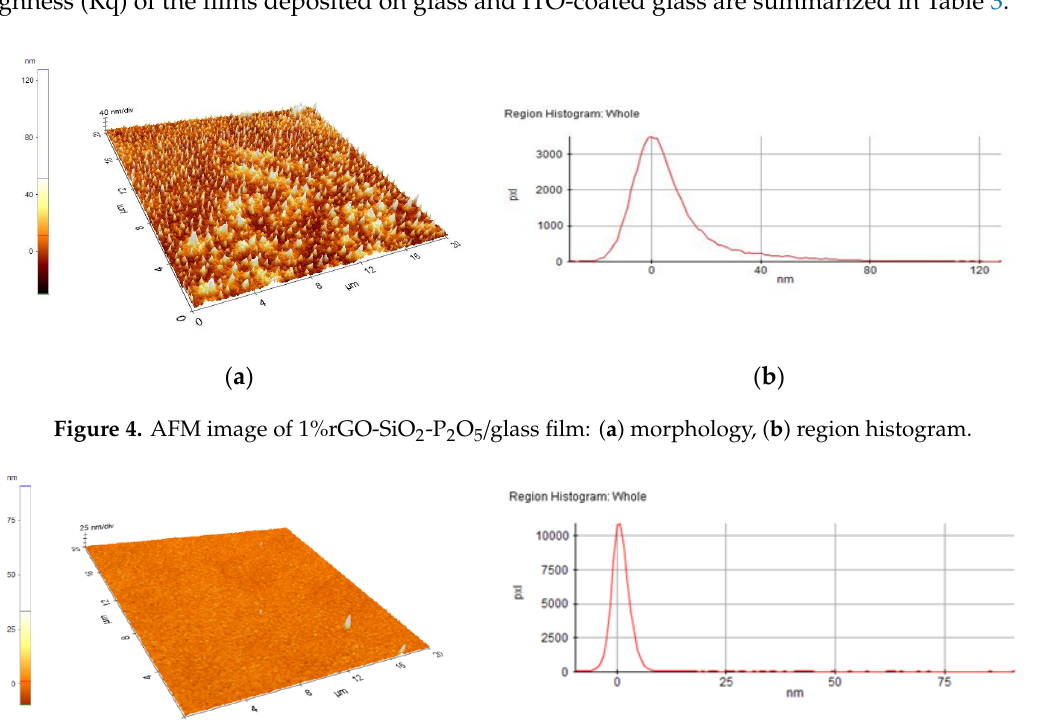
Table 3. The root-mean-squared roughness (Rq) and peak-to-valley (Rpv) from atomic force microscopy (AFM) investigations.